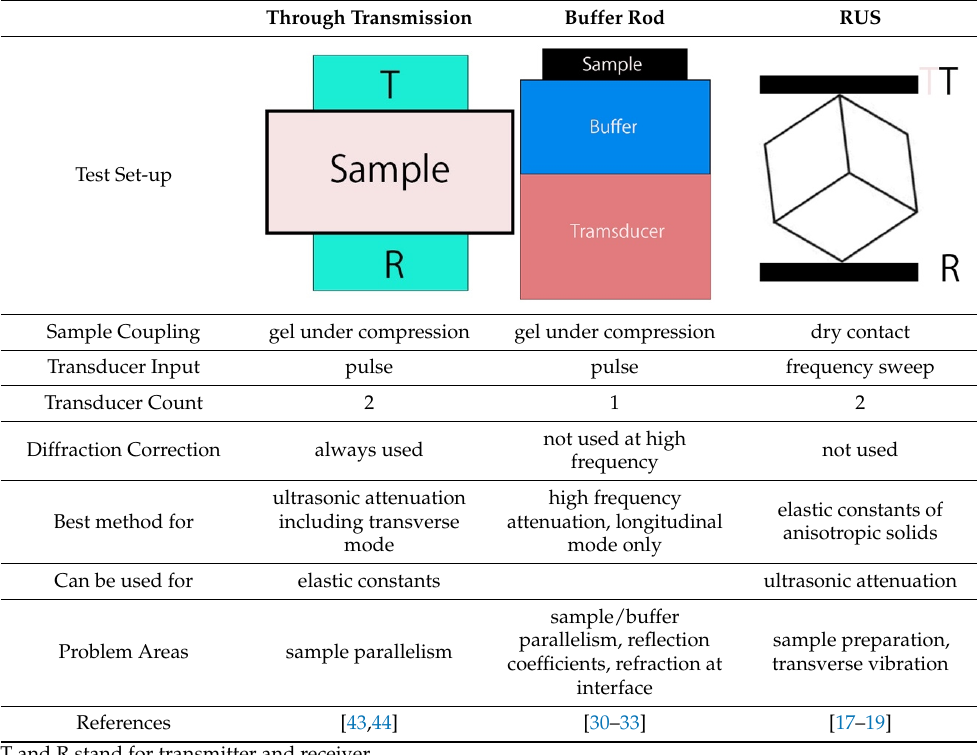
Table 2. Comparison of Test Methods.